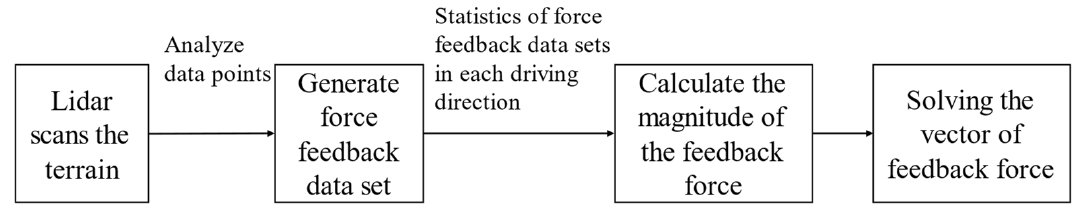
Figure 13. Flow chart of force feedback solution.